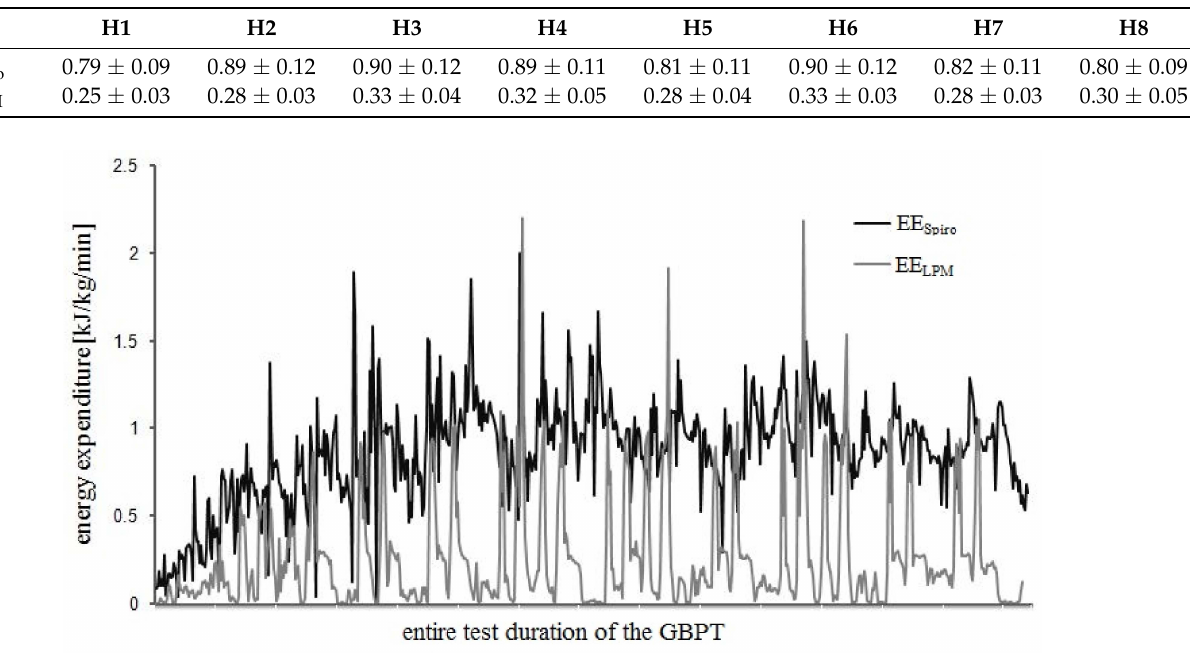
Table 3. Mean ( ± standard deviation) energy expenditure [kJ/kg/min] via spiroergometry (EE Spiro ) and via local position measurement (EE LPM ) of all participants for each heat (H1–H8).